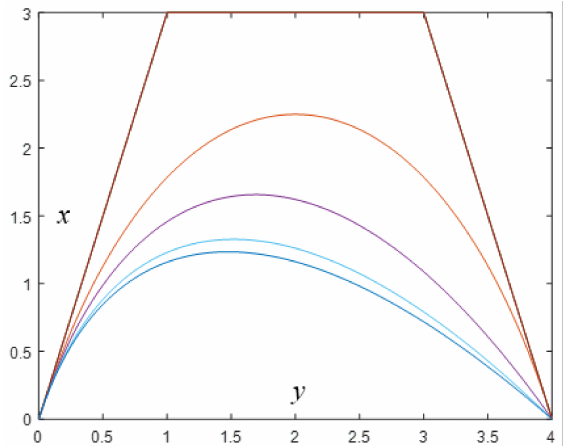
Figure 1. The cubic Q-B é zier curve with the shape parameter q increasing (from bottom to the